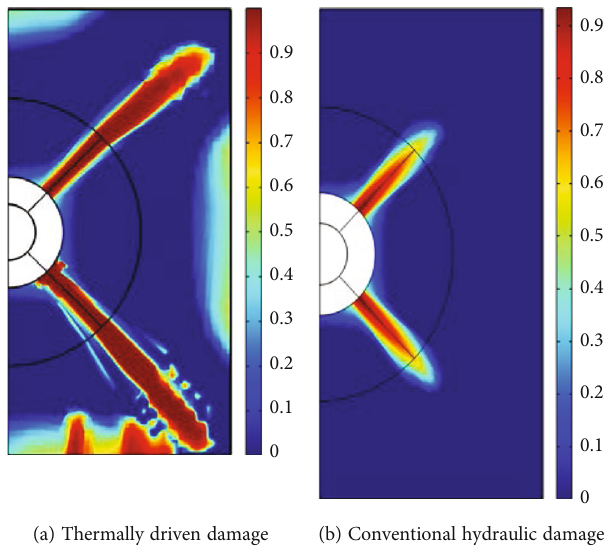
Figure 21: Comparison diagram of thermally driven fracturing and conventional hydraulic